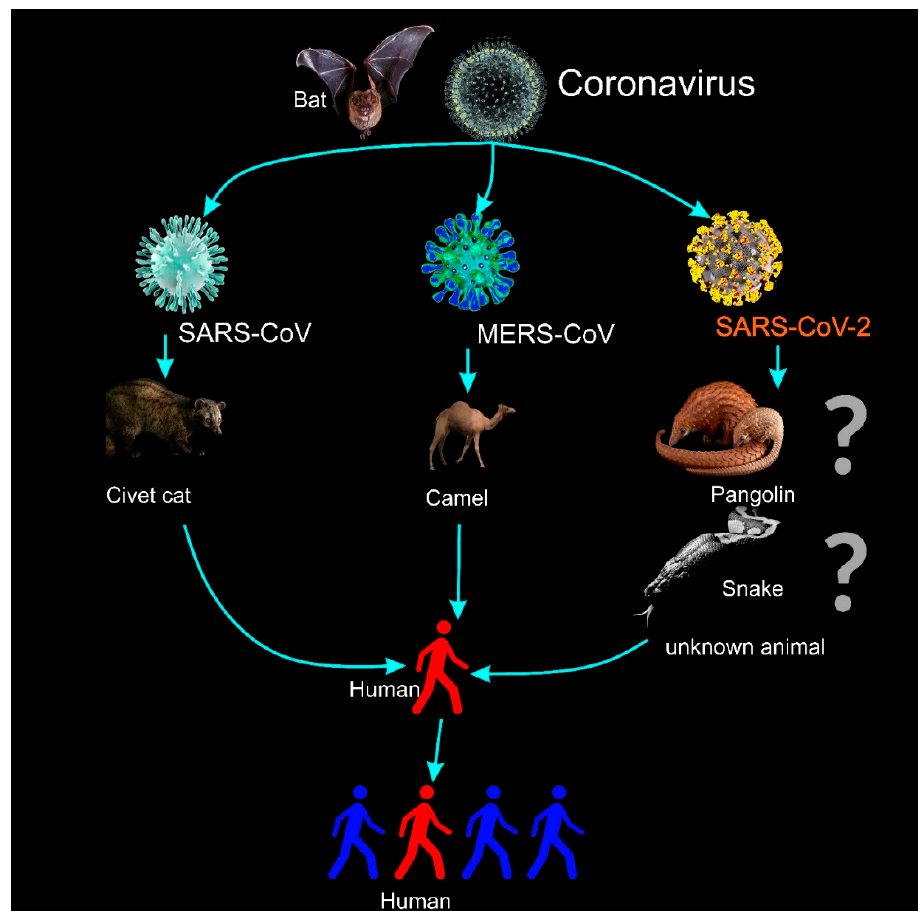
Figure 1. The illustration for the transmission of coronaviruses and the 2019 novel Coronavirus (2019-nCoV or SARS-CoV-2 [11]). Current studies have suggested that the intermediate carriers may be snakes [12] or pangolins [13], but according to WHO the real source is still unknown [14,15]. Table 1. Coronaviruses (CoVs) and 2019 novel coronavirus (SARS-CoV-2). Virus Description